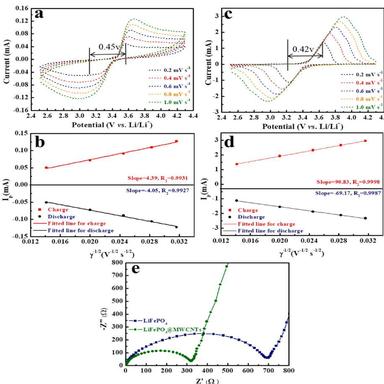
CV curves of LiFePO4 (a) and LiFePO4@MWCNTs composite (b) at different scanning rates; Relationship between the peak current and the square root of the scanning rate (c–d); Electrochemical impedance spectra (e).